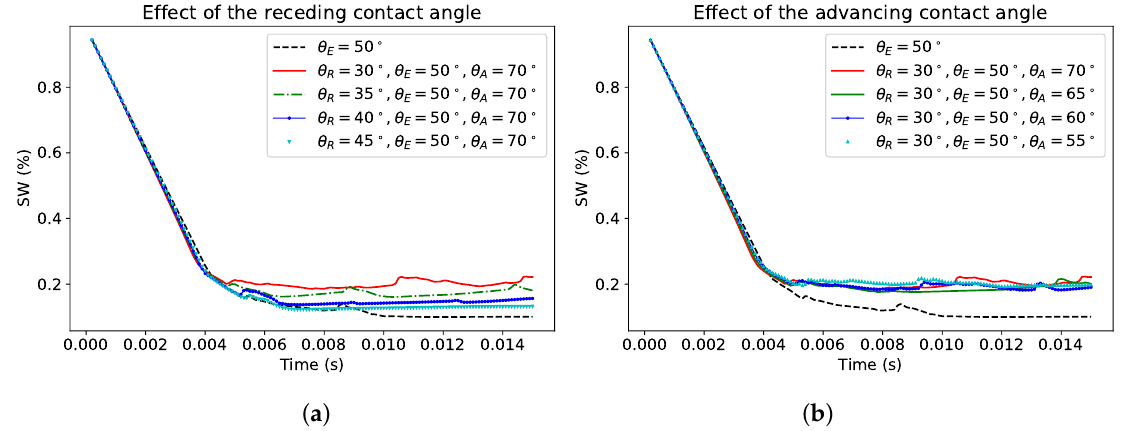
Figure 9. The evolution of the water saturation function of the contact angles under drainage for ( a ) water-wet and ( b ) oil-wet configurations, respectively.